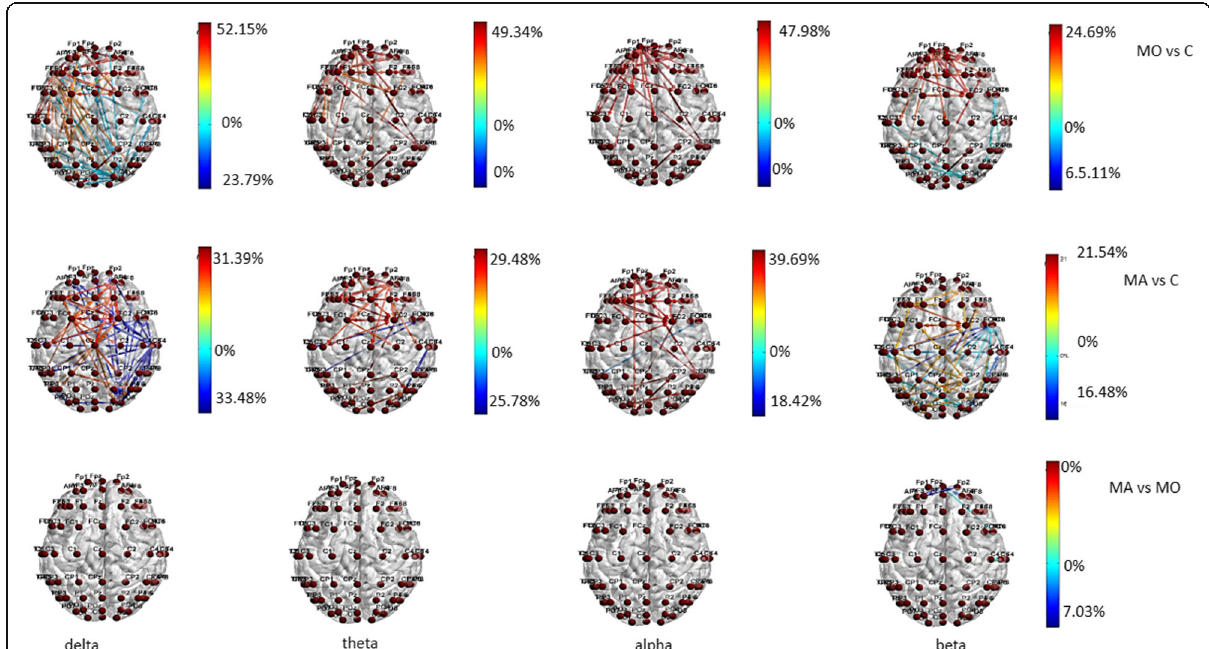
Fig. 3 Statistical differences in information transfer and their relative directions among nodes during 0.5 cpd spetial frequency are depicted in the Migraine with aura (MA), Migraine without aura (MO) and Controls (C) groups . Hot colors refer to a statistical prevalence of information transfer in the first element of the comparison, and cold colors for the vice-versa. The color intensity is graduated on the relative percent difference. (further data on statistical analysis are available in the Additional file 1: section, chapter 5.6.1)